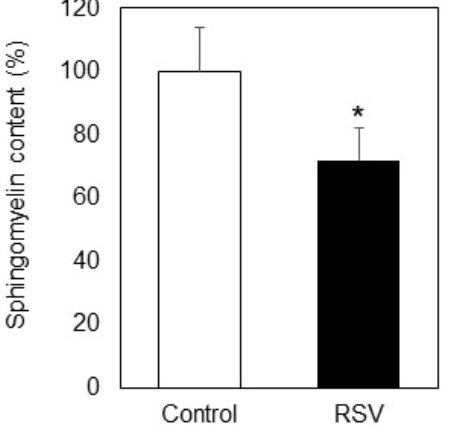
Figure 1. Sphingomyelin (SM) content in plasma membranes isolated from A549 cells untreated (Control, white bars) and treated with resveratrol (RSV, black bars). Values are expressed as relative percentage participation in the total lipids. Values are means ± SD. * p < 0.01.